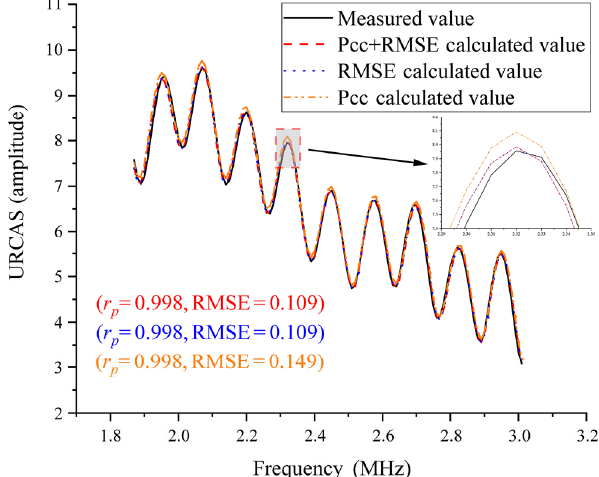
Fig. 12 Effect of different objective functions on URCAS.